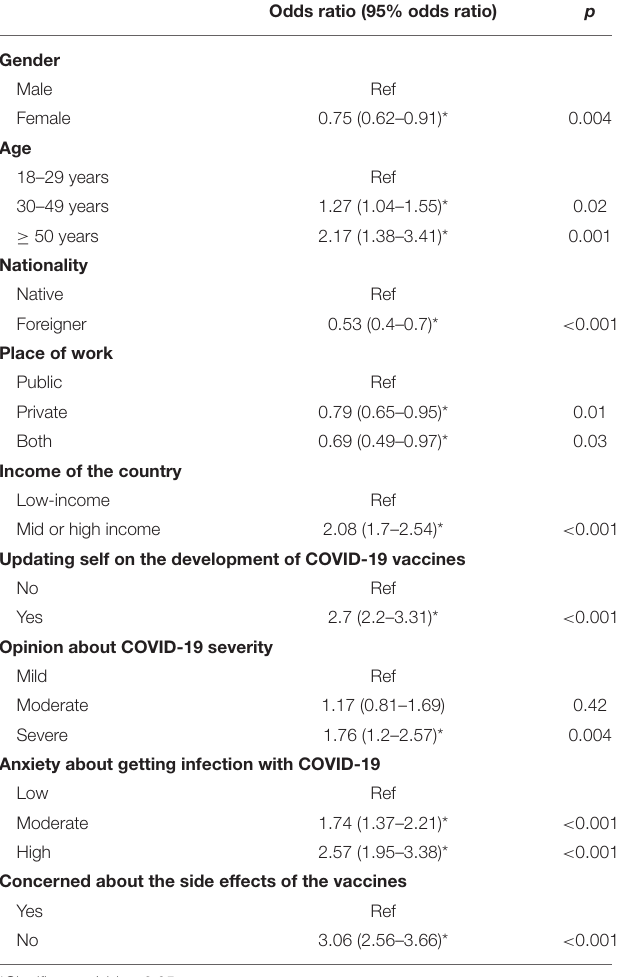
TABLE 6 | Predictors of agreement to accept a COVID-19